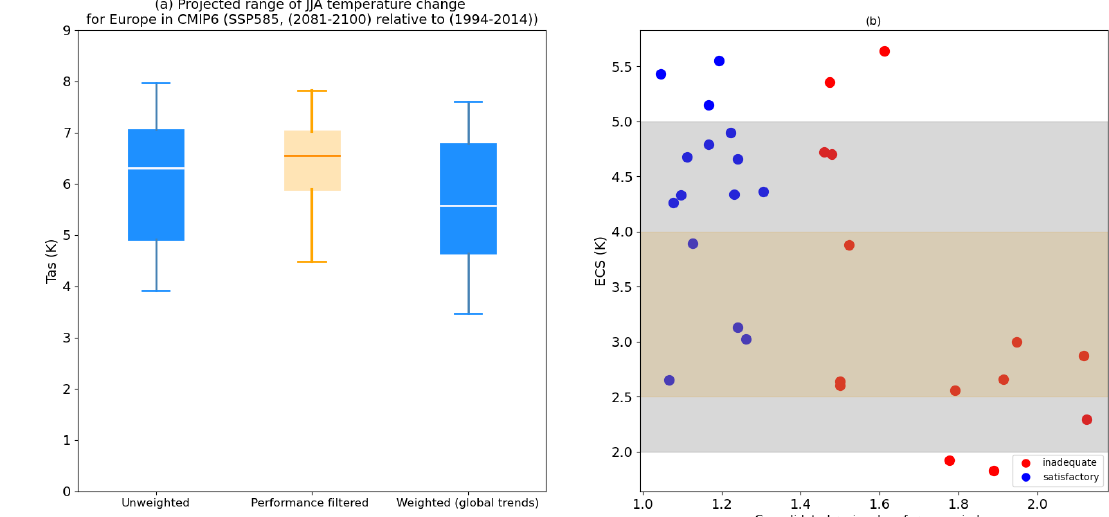
Figure 7. (a) Projected range of JJA temperature change for Europe in CMIP6 (SSP585; 2081–2100 relative to 1994–2014) for the raw unweighted multi-model ensemble, the performance-filtered subset and the raw ensemble weighted for performance against global trends using the ClimWIP method. Boxes show the 25th to 75th percentiles. Whiskers show the 5th and 95th percentiles. (b) CMIP6 model ECS compared to consolidated regional performance index. The yellow bounds show the IPCC AR6 likely range for ECS; the grey bounds show the very-likely